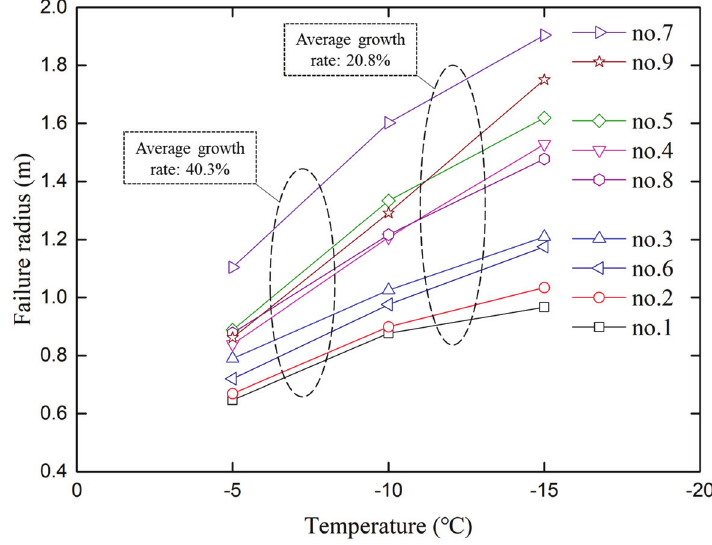
Figure 19. Change curve of failure radii of foundations of nine sizes at three temperatures.